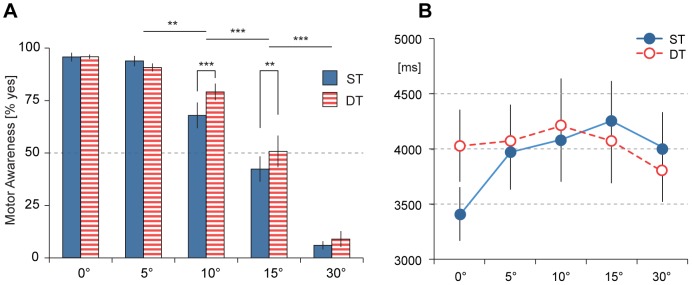
Motor Awareness and Response Times.
A Participants correctly judged feedback in 0° control trials to be true. This self-attribution significantly decreased with increasing angular deviations. In case of the largest deviations of ±30° participants correctly rejected almost all trials as deviated. Cognitive loading significantly impaired motor awareness for trials with deviations of ±10° to ±15° as participants judged significantly more trials to be non-deviated than in the single task condition. B Response times (RT) were recorded for all trials. Participants were instructed to respond promptly but the priority was placed on completing the task correctly. In the single task condition participants replied fastest for the 0° control trials, with RTs increasing almost linearly with increasing deviation. RTs decreased for trials with the largest deviations of 30° in both the ST and DT condition. All error bars are SEM.